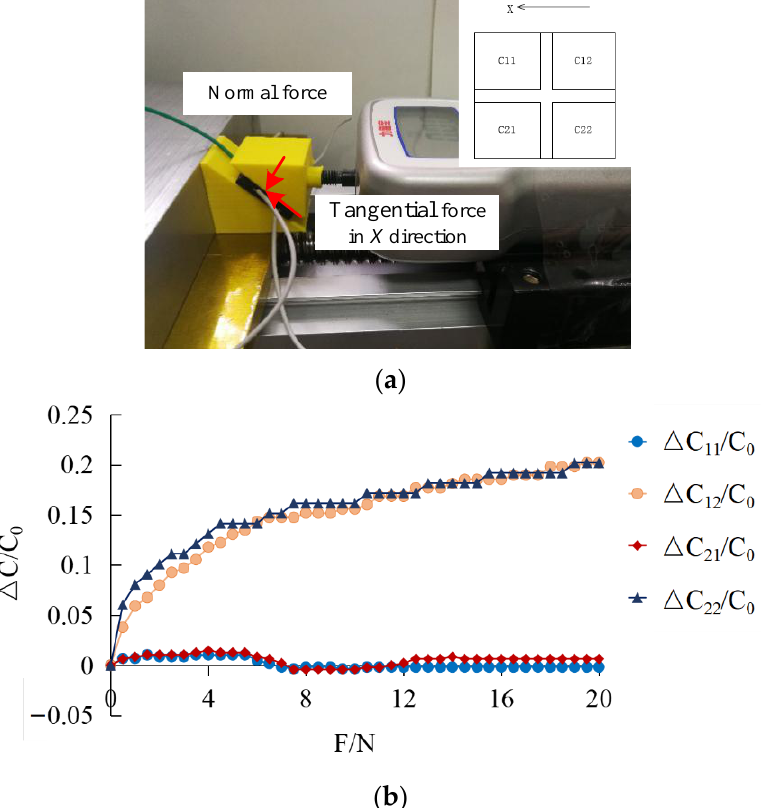
Figure 16. ( a ) Multidirectional force test platform; ( b ) output capacitance value of multi-directional force.